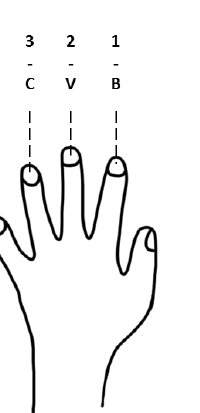
Figure 2. Visualization of the procedural memory task. ( A ) Participants used their non-dominant left hand to type the desired sequence. Each finger was assigned to a specific keyboard key that represented a number of the desired sequence. ( B ) Participants were shown a specific 5-element sequence on a screen and were instructed to type the desired sequence as frequently and accurately as possible for each trial (30 s) over the course of 12 trials; each trial was separated by an inter-trial interval (ITI) of 30 s. Subsequent delayed recall consisted of only four trials.